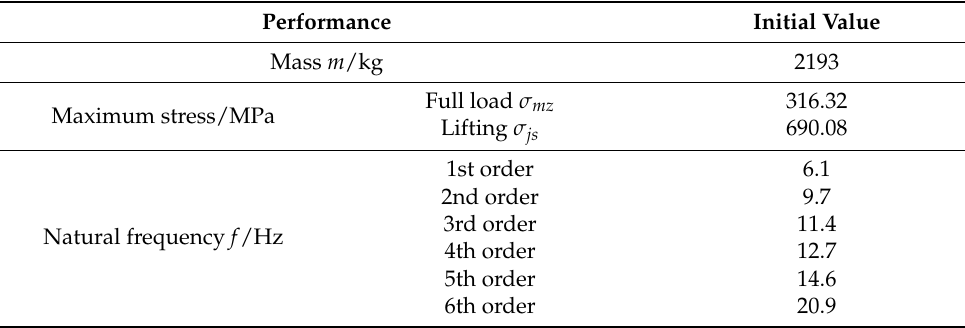
Figure 8. Stress contour: ( a ) Full load case; ( b ) Lifting load case. Table 2. Initial performance analysis of carriage.